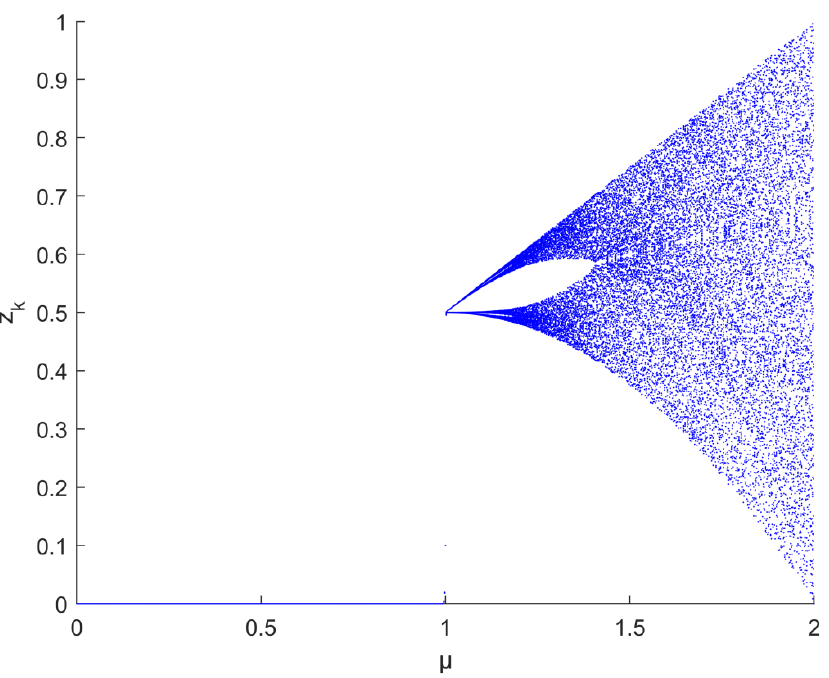
Figure 2. Tent-Mapping Bifurcation Chart.